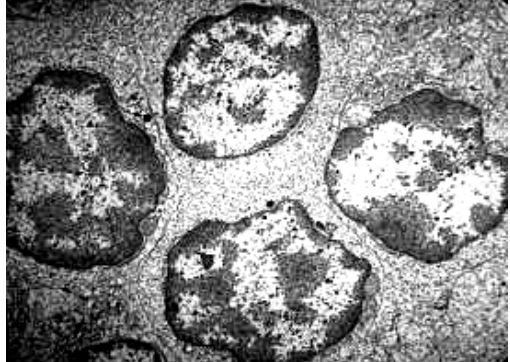
Fig. 9. Electronogram of lymphocytes of paracortical lym- phatic zone of pigs, 1 st group, the 70 nd day of test. x 6000